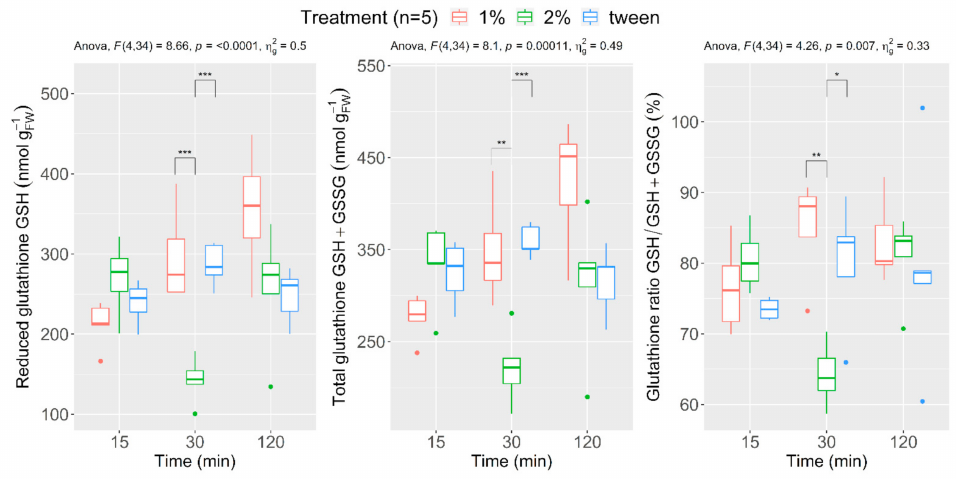
Figure 1. Effect of C. cassia EO (CEO) (1 and 2% v / v ) and tween 80 application on glutathione leaf content over time ( n = 5): ( left ) Reduced glutathione GSH (nmol g − 1 FW ); ( center ) Total glutathione GSH+GSSG (nmol g − 1 FW ;) ( right ) the glutathione ratio GSH/GSH+GSSG (%). Star on boxplot indicates significantly different distributions (* p < 0.05, ** p < 0.01, *** p < 0.001, pairwise t